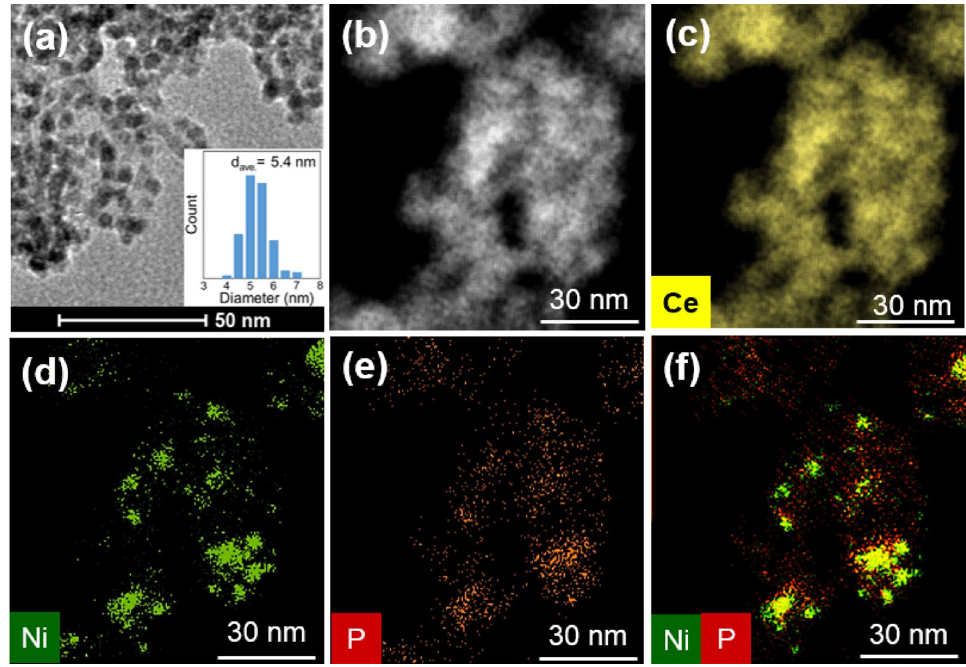
Figure 1. ( a ) TEM image of nano-Ni 2 P (the inset shows the histogram of nano-Ni 2 P). ( b ) HAADF-STEM image of nano-Ni 2 P/CeO 2 . Elemental mapping of ( c ) Ce, ( d ) Ni, and ( e ) P, and ( f ) a composite overlay of ( d , e ).